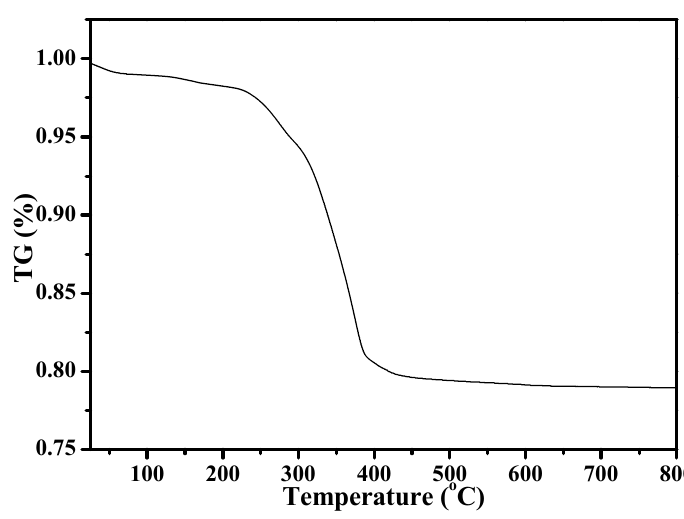
Figure 3. Thermogravimetric analysis (TG) curve of as-synthesized S-Beta zeolite.